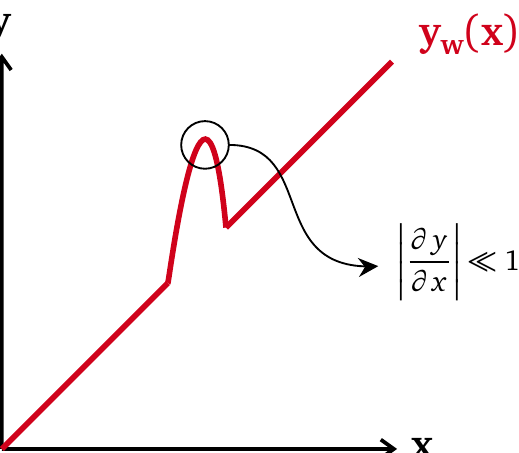
Figure 8: A one-dimensional illustration of why a non-injective region (“folding”) in the map necessarily gives rise to a small